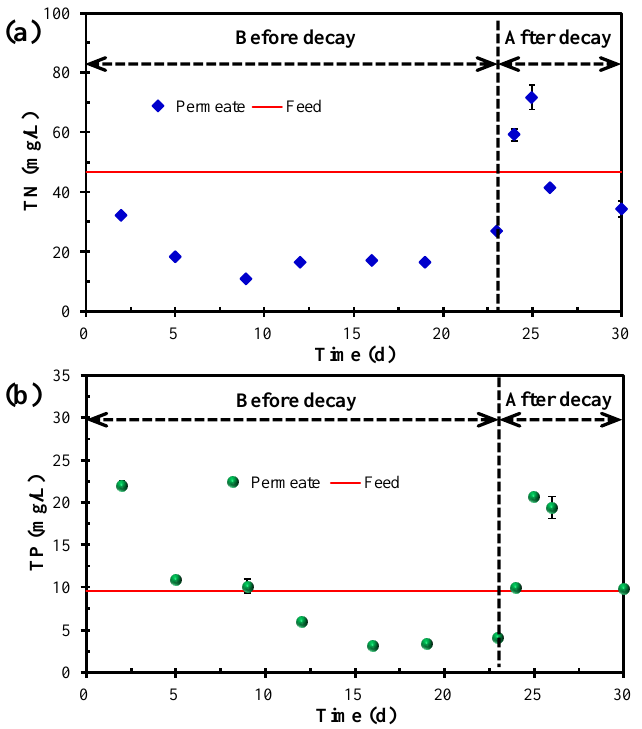
Figure 3. Variation in ( a ) TN and ( b ) TP in the feed and permeate.